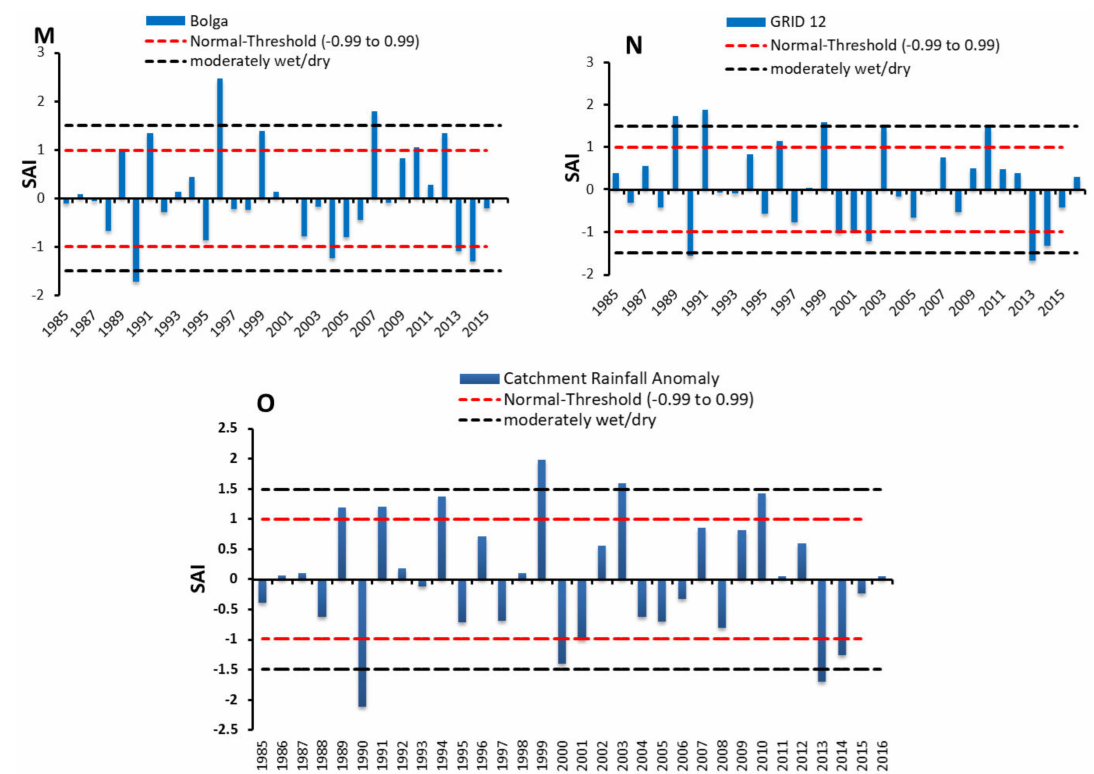
Figure 3. Mean Annual Standardized Anomaly Index from 1985 to 2016 for the individual locations ( A – N ) and Catchment Scale ( O